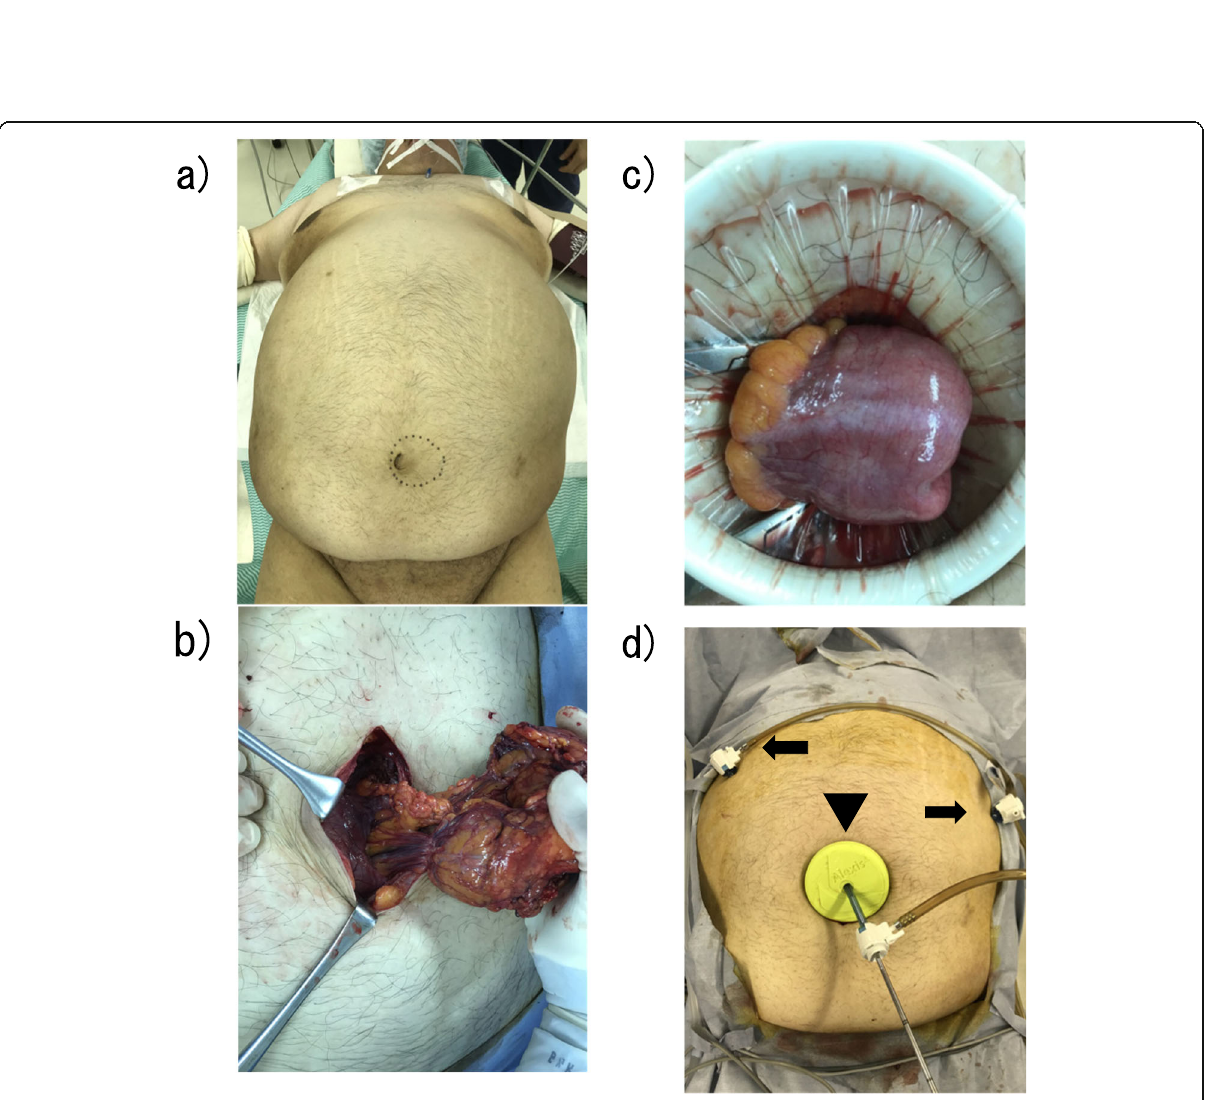
Fig. 3 Incarcerated umbilical hernia release. a Surgical position. b Incarceration of the omentum in the hernia sac is evident. c No perforation or necrotic changes are evident in the incarcerated small intestine. d Alexis® laparoscopic system (arrowhead) and 5-mm trocar